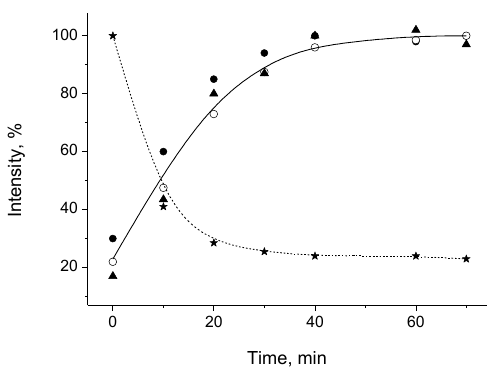
Figure 7. Dependences of EPR signal intensity as a function of UV illumination time for Ti 3+surf ( ▲ ), N • radical ( star ), Mo 5 + ( ○ ), and V 4+ (●) PCs.